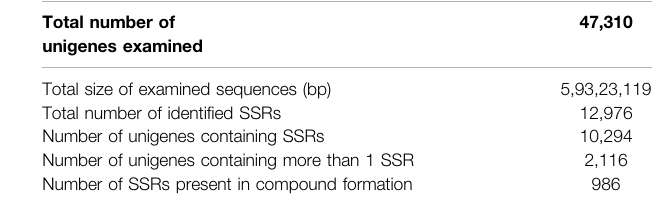
TABLE 2 | Statistics related to SSRs obtained from the transcriptome of Pennisetum glaucum .